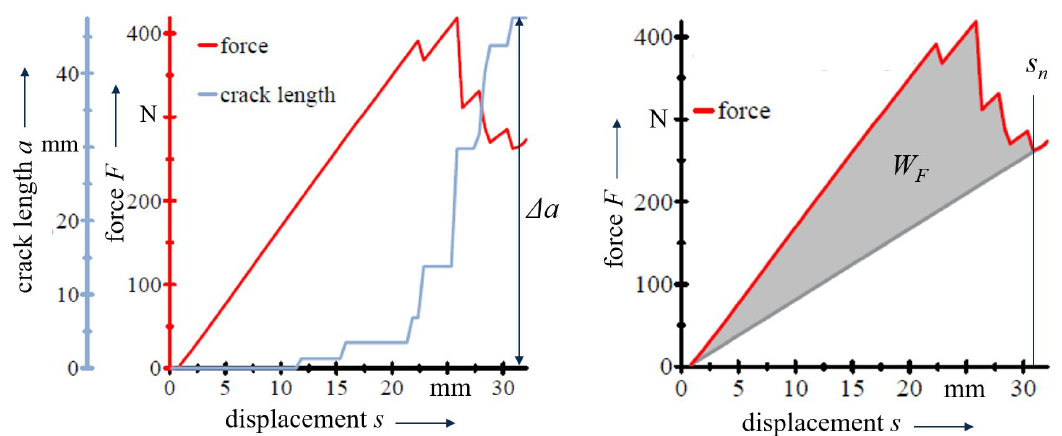
Figure 4. Analysis of energy release rate values based on force–displacement results and synchronous crack length measurements.